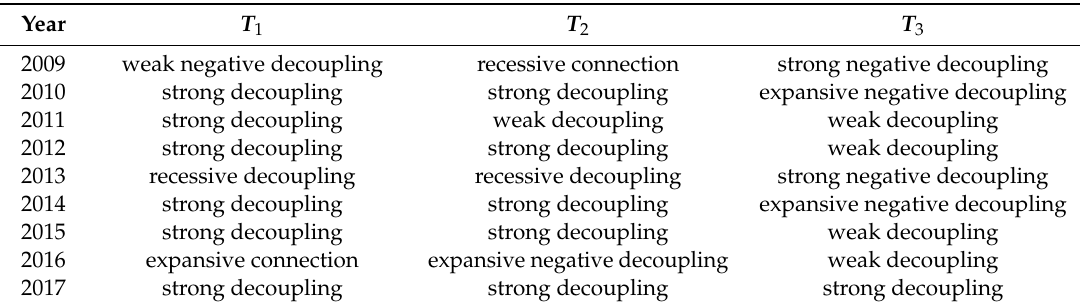
Table 6. Status of the decoupling index for each